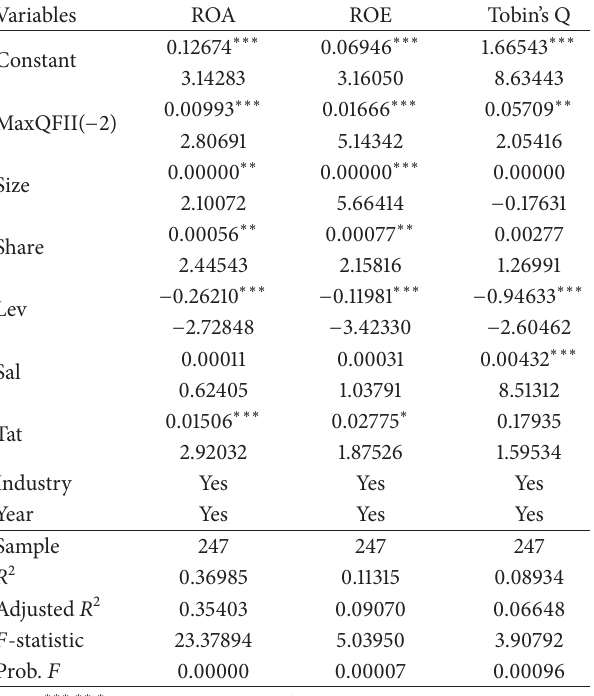
Table 6: Regression results of QFII investment ratio in period ( 𝑡−2 ) and company performance according to MODEL